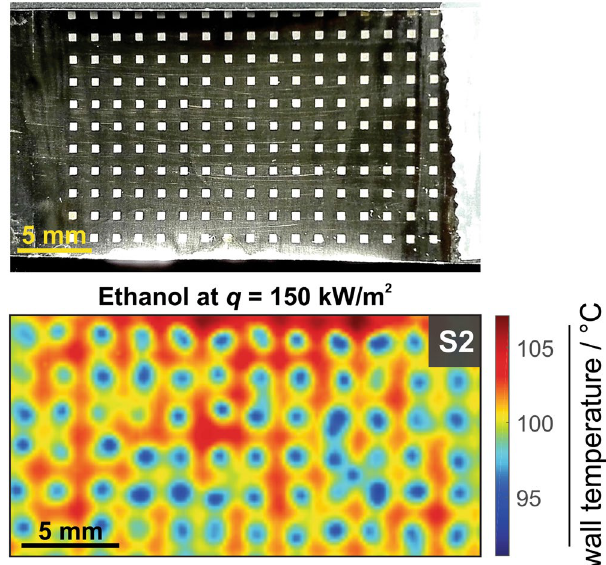
Figure 4. Controlled nucleate boiling performance of ethanol. Photography of laser-textured pattern of S2 structure (top) and average temperature fields of saturated nucleate boiling of ethanol at 150 kW m − 2